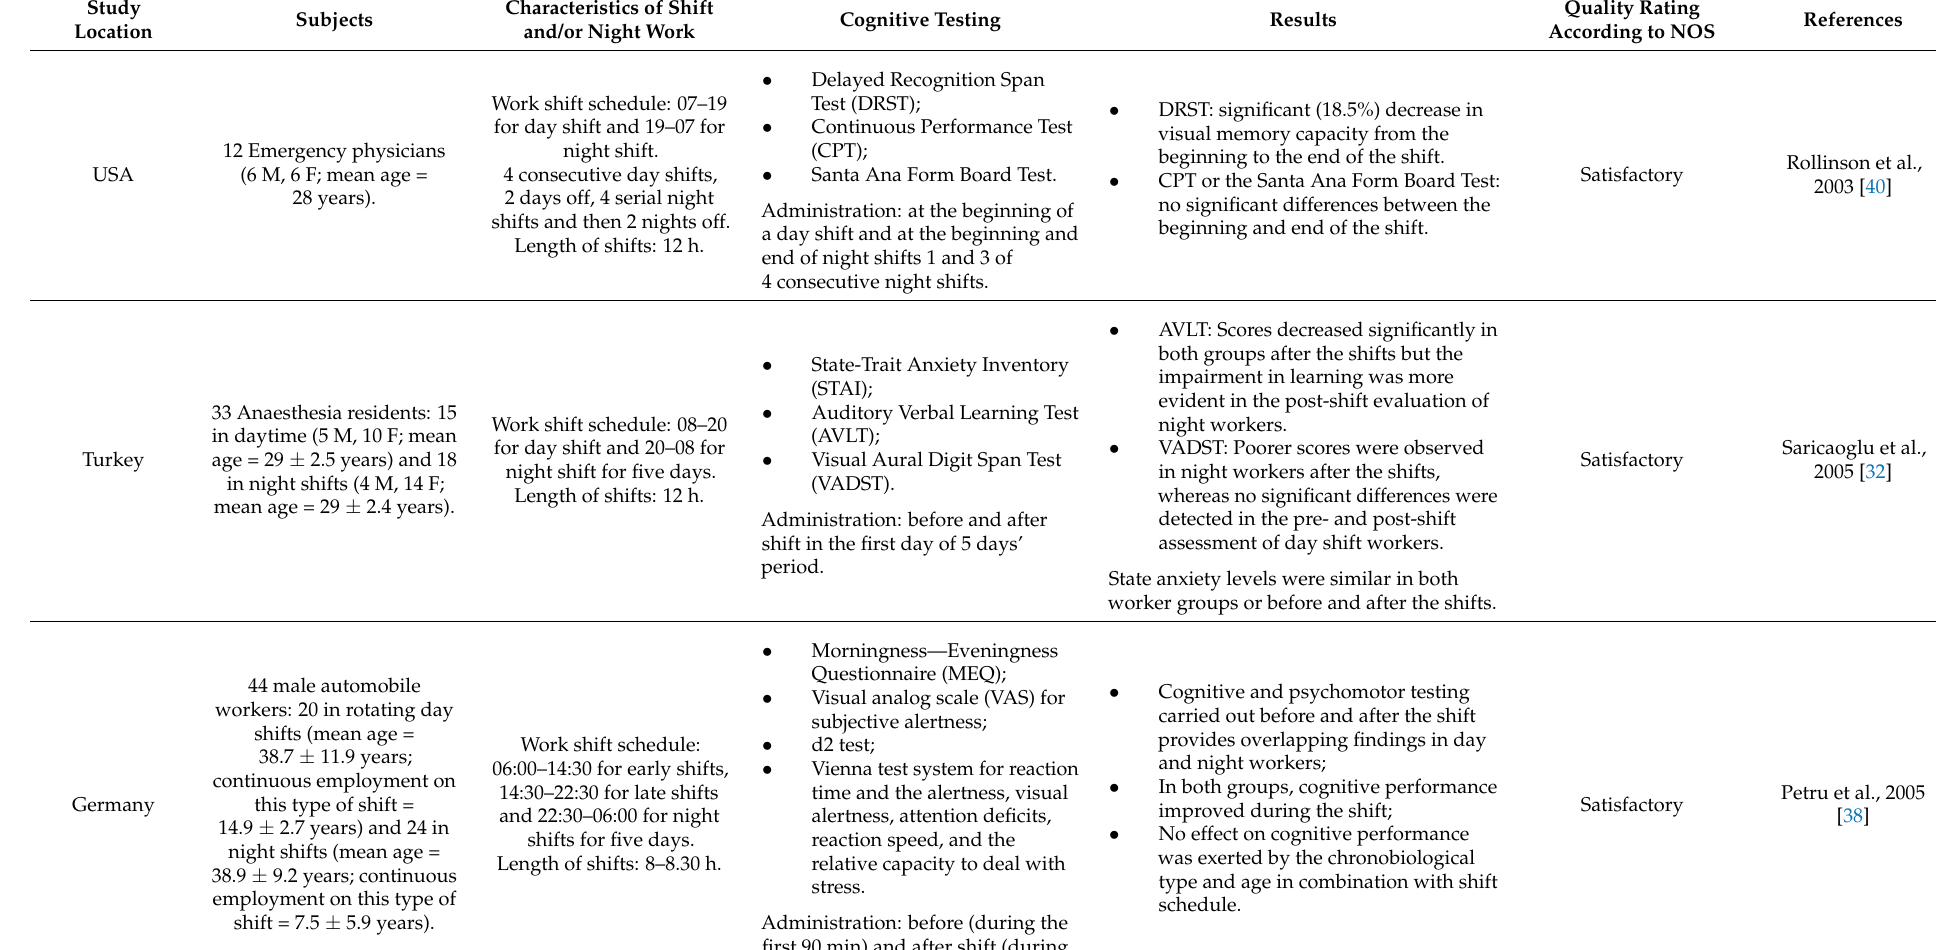
Table 2. Studies addressing short-term effects induced by shift work and single or consecutive night shifts on cognitive functions. Study